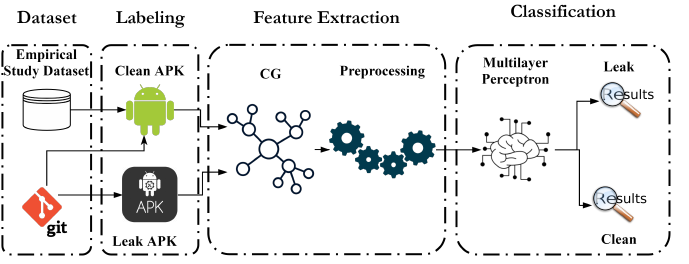
Figure 1. Multilayer perceptron (MLP) Model to Detect Wake Lock